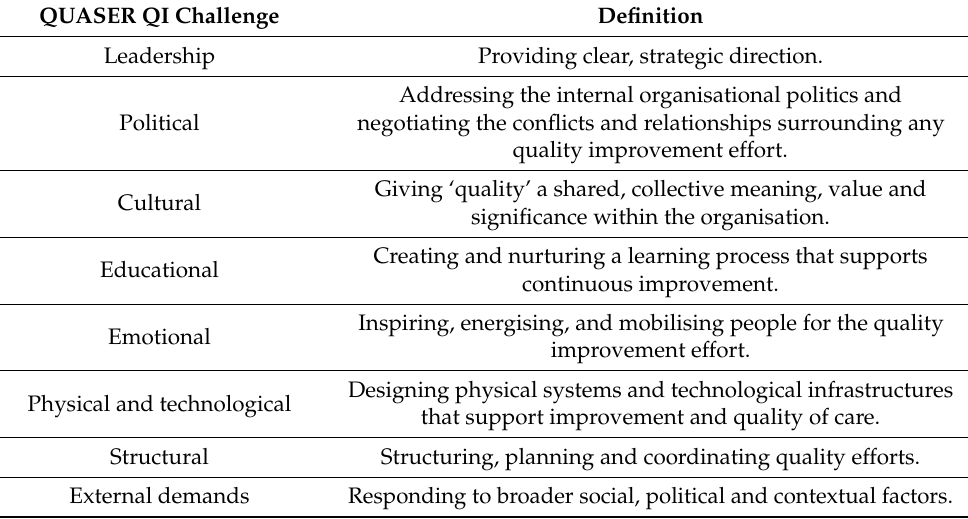
Table 1. QUASER guide to the eight challenges of quality improvement with definition